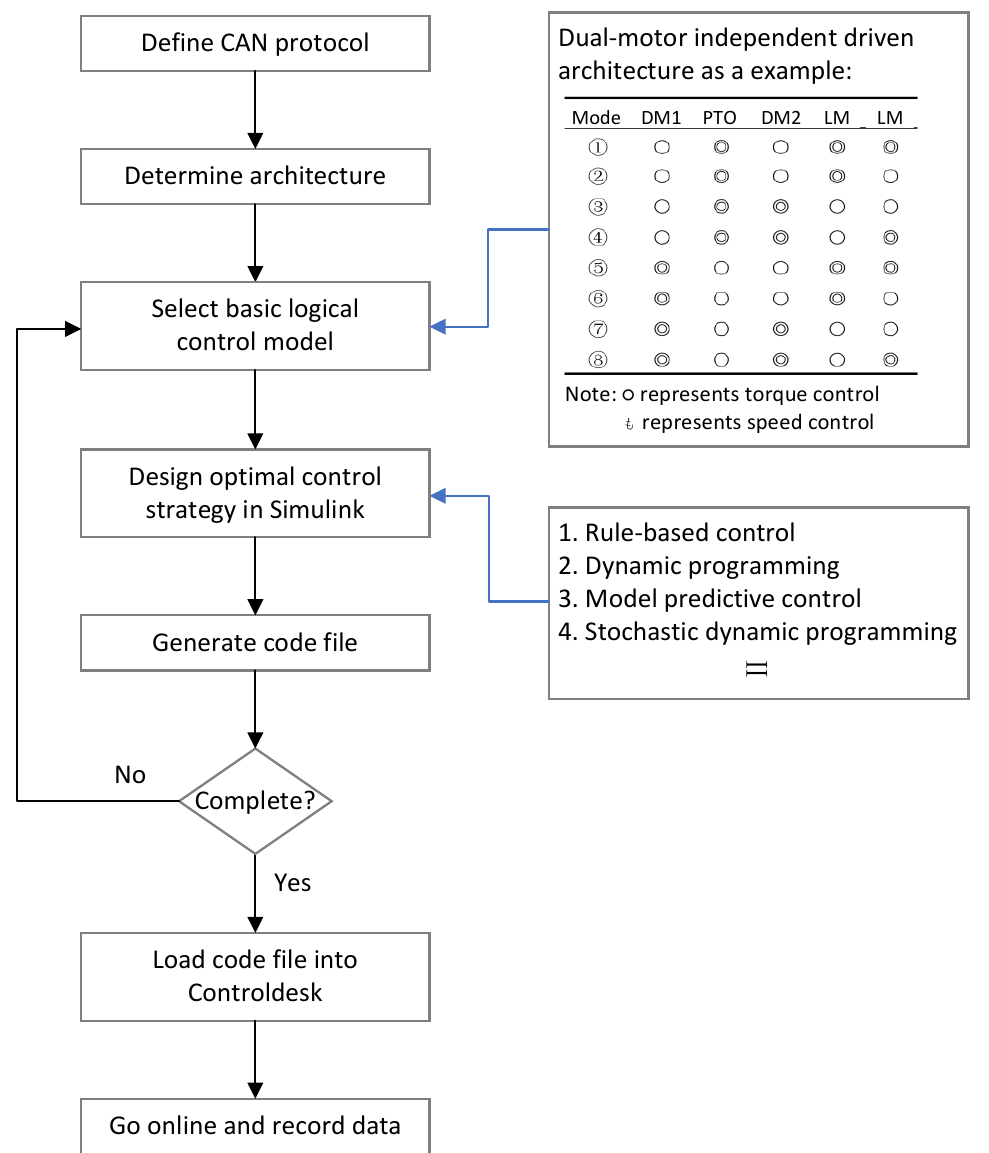
Figure 4. The control modeling flow chart.